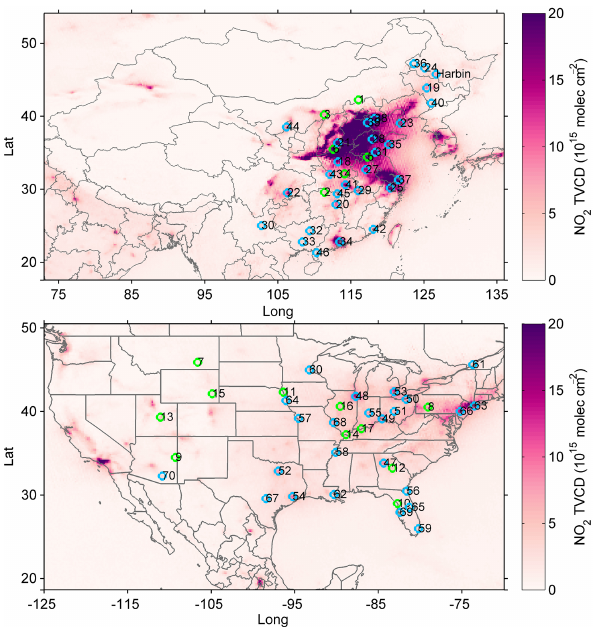
Figure 5. Average OMI NO 2 TVCDs during ozone season (i.e., May to September) over China and the USA for the period 2005– 2013. Green and blue symbols indicate the 17 power plants and 53 cities investigated in this work, respectively. Power plants and cities are labeled by their IDs (see Table S2). Figure 6. Fitted NO x lifetimes (color coded) for investigated emis-